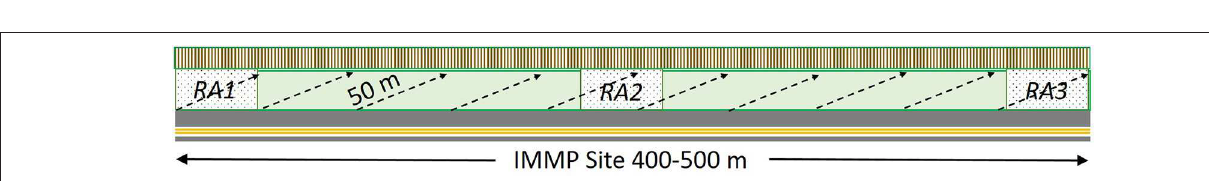
FIGURE 1 | The Rapid Assessment of Roadside Habitat for Monarchs, showing an example of how an observer might move from a starting point 45.7m along a roadside, then systematically zig-zagging throughout the right-of-way to characterize habitat conditions. The survey area for a Rapid Assessment is the 45.7m by the width of the right-of-way (ROW) from the road to the adjacent land at the back of the ROW.